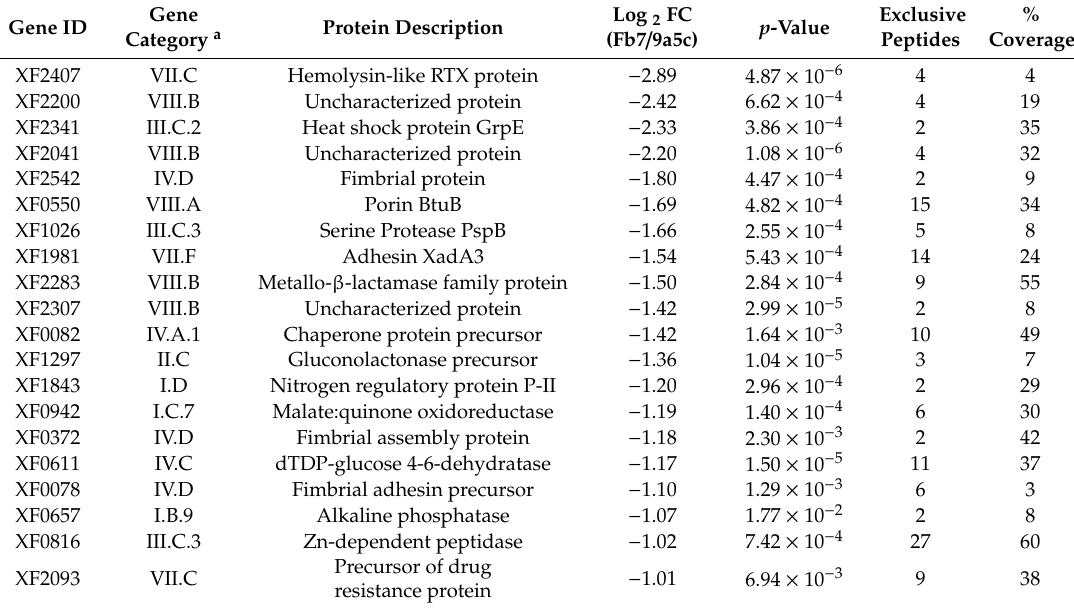
Table 2. Top 20 cellular extract proteins with higher abundance in X. fastidiosa subsp. pauca strain 9a5c over strain Fb7 of the same